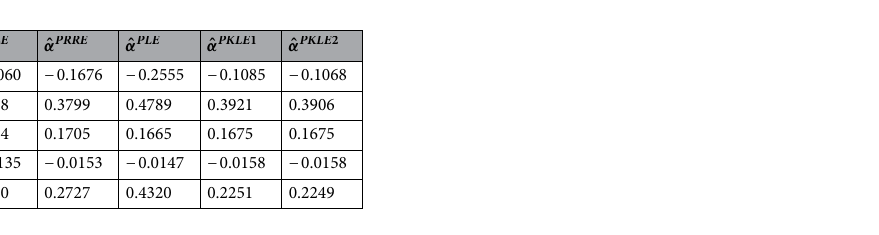
Table 7. Regression coefficients and